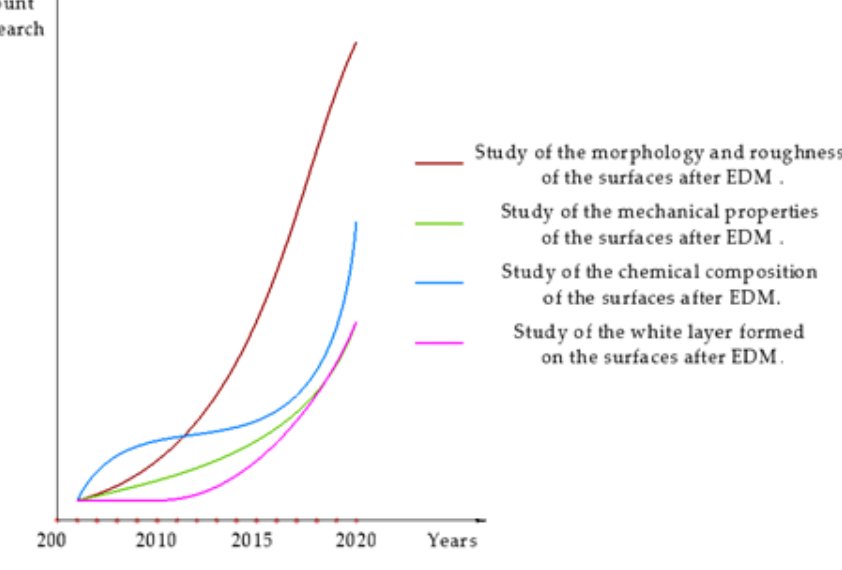
Figure 3. Dynamics of research in the field of EDM.